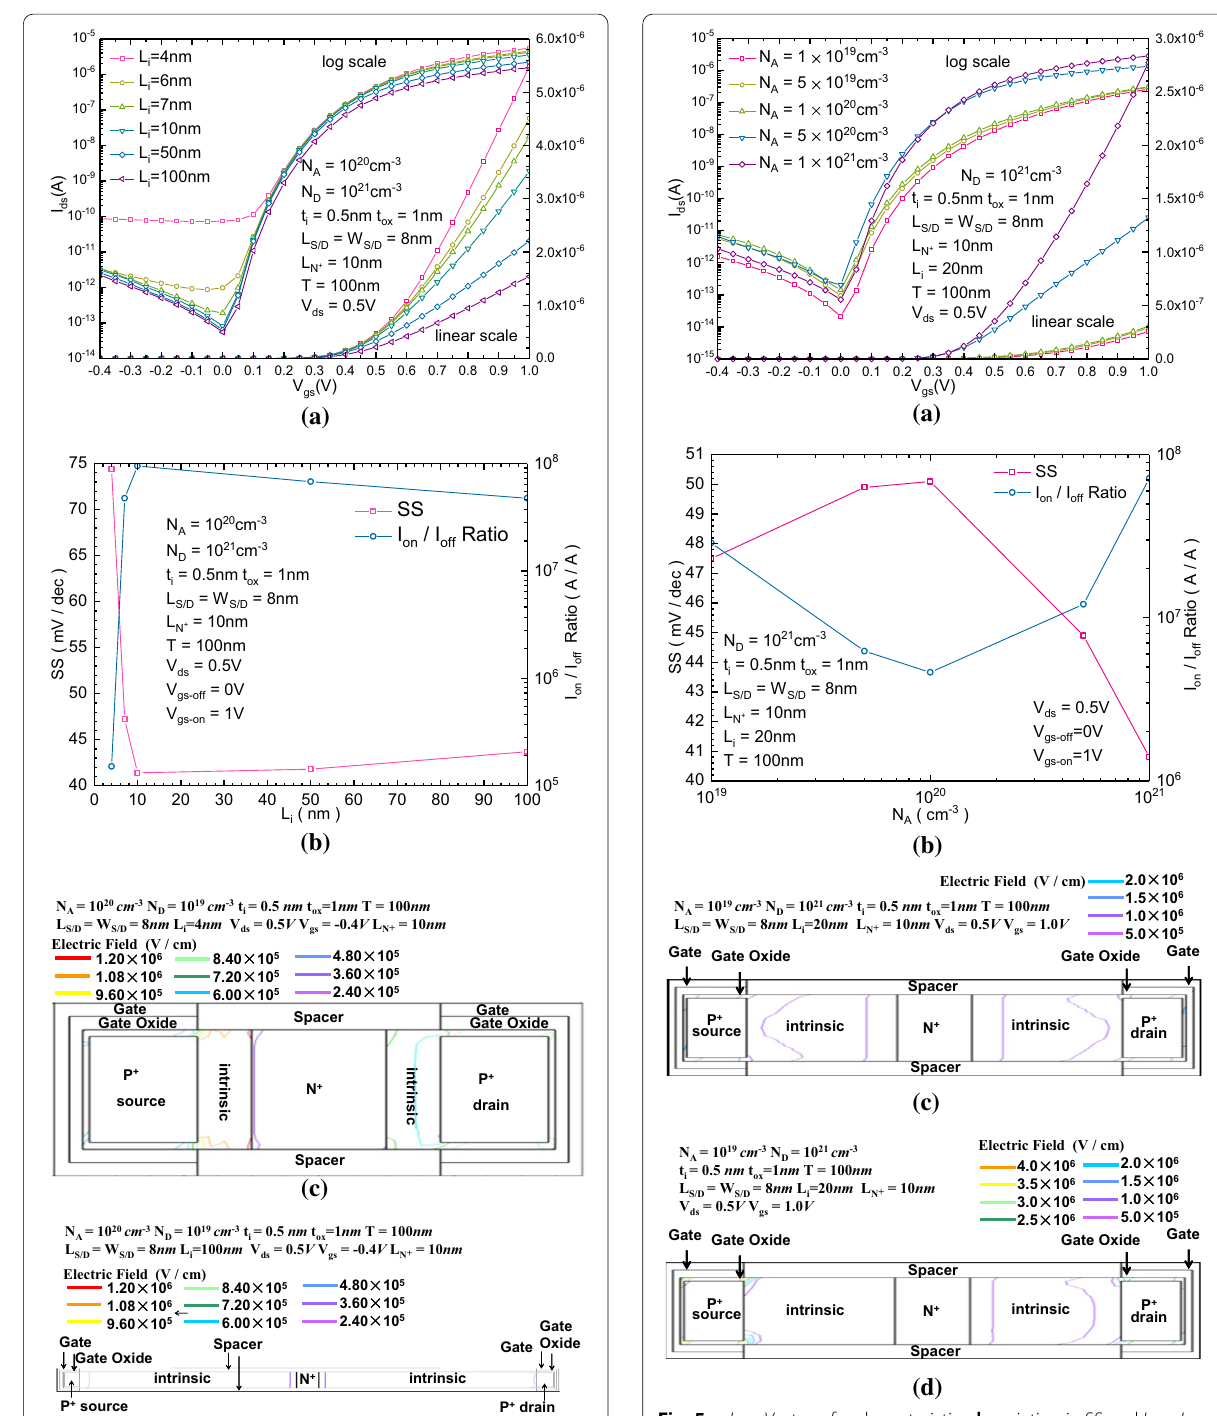
Fig. 5 a I ds − V gs transfer characteristics, b variation in SS and I on − I off ratio of the proposed B‑TFET with different N A . Two‑dimensional reversely biased electric field distribution of the proposed B‑TFET for N A equal to (3) 10 19 cm − 3 and (4) 10 21 cm −